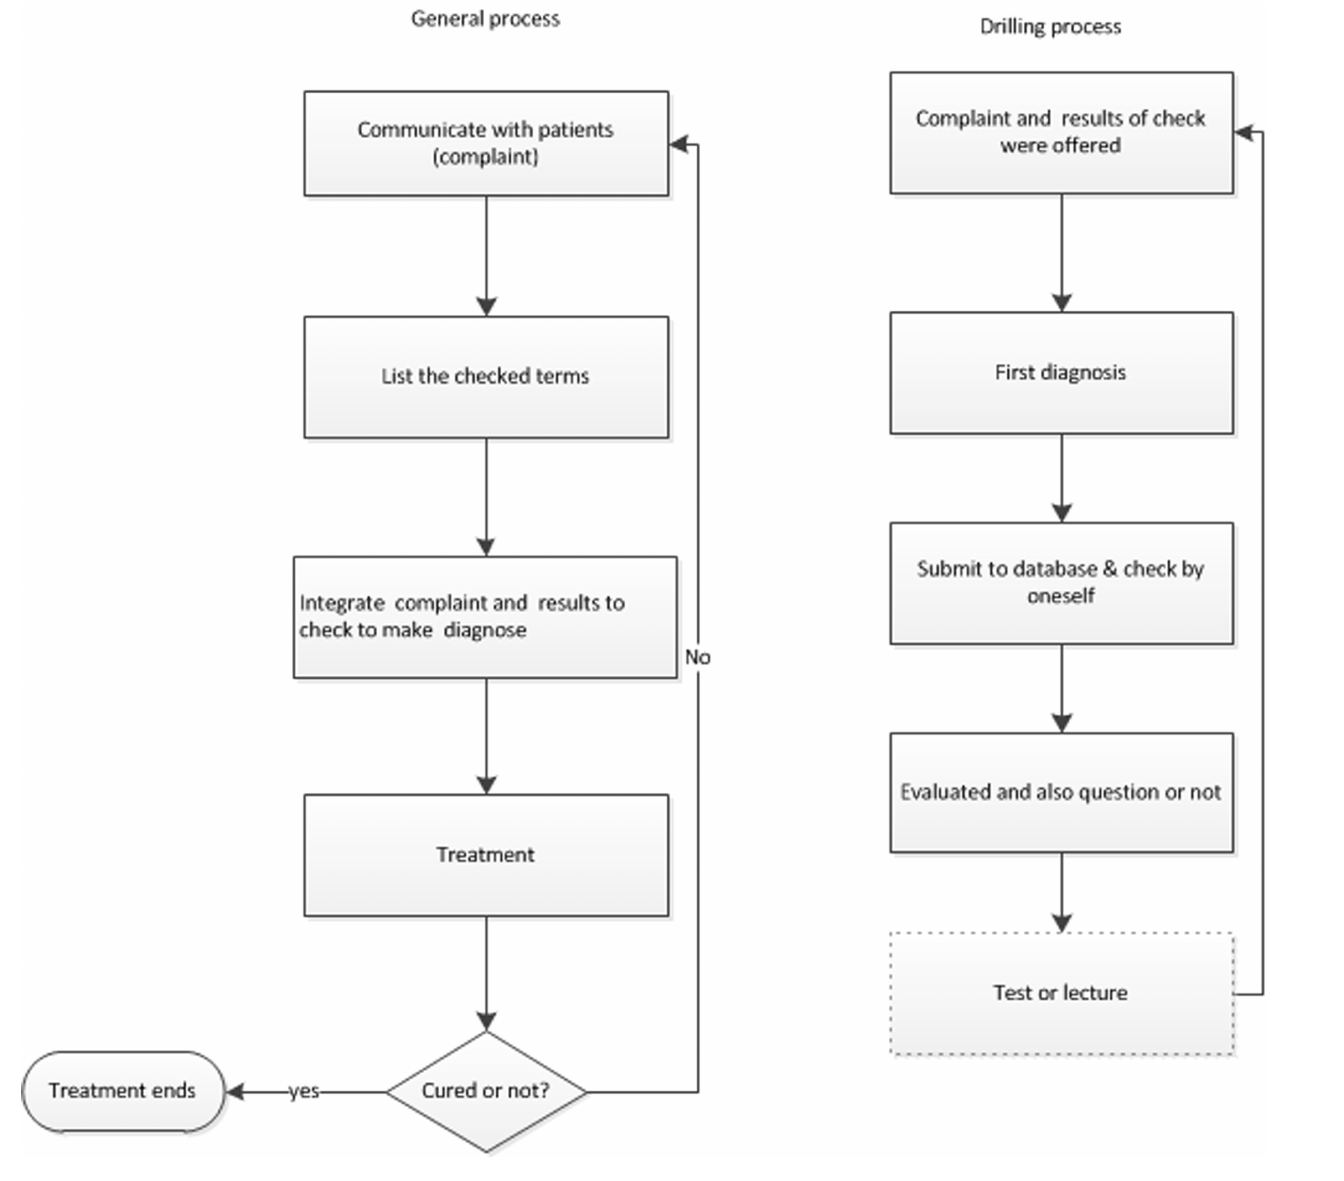
Figure 1. Drilling process and the general process: action in the dotted box occurred at some time or not, which is decided by tutors. group differences in post-test scores using the first-score as a covariate. Finally, a generalized mixed-effort model using a group, TP and a group 6 TP interaction as a fixed effect, and intercept as a random effect were used to compare the trajectory change in test scores over time between groups. Statistical analyses were performed using SPSS version 17.0 (SPSS Inc., Chicago, IL, USA). Statistical significance was set at a p value # 0.05.